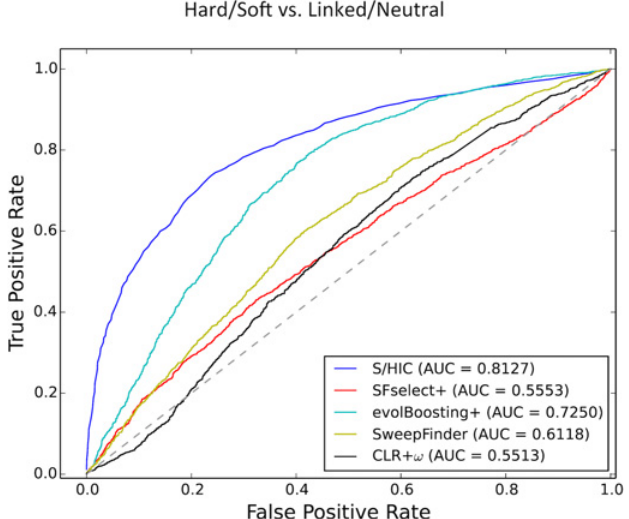
Fig 6. ROC curves showing the true and false positive rates of various methods/statistics when tasked with discriminating between regions containing a sweep (either hard or soft) and unselected regions (either neutral or linked to sweeps) when testing on simulations with Tennessen et al. ’ s European demographic model. Here, α ~ U (5×10 3 , 5×10 5 ), and the methods that require training from simulated sweeps were trained from the same simulations with equilibrium demography as used for Figs 2 – 5. Note that Tajima ’ s D and Kim and Nielsen ’ s ω were omitted from this figure, as we simply used the values of these statistics to generate ROC curves without respect to any demographic